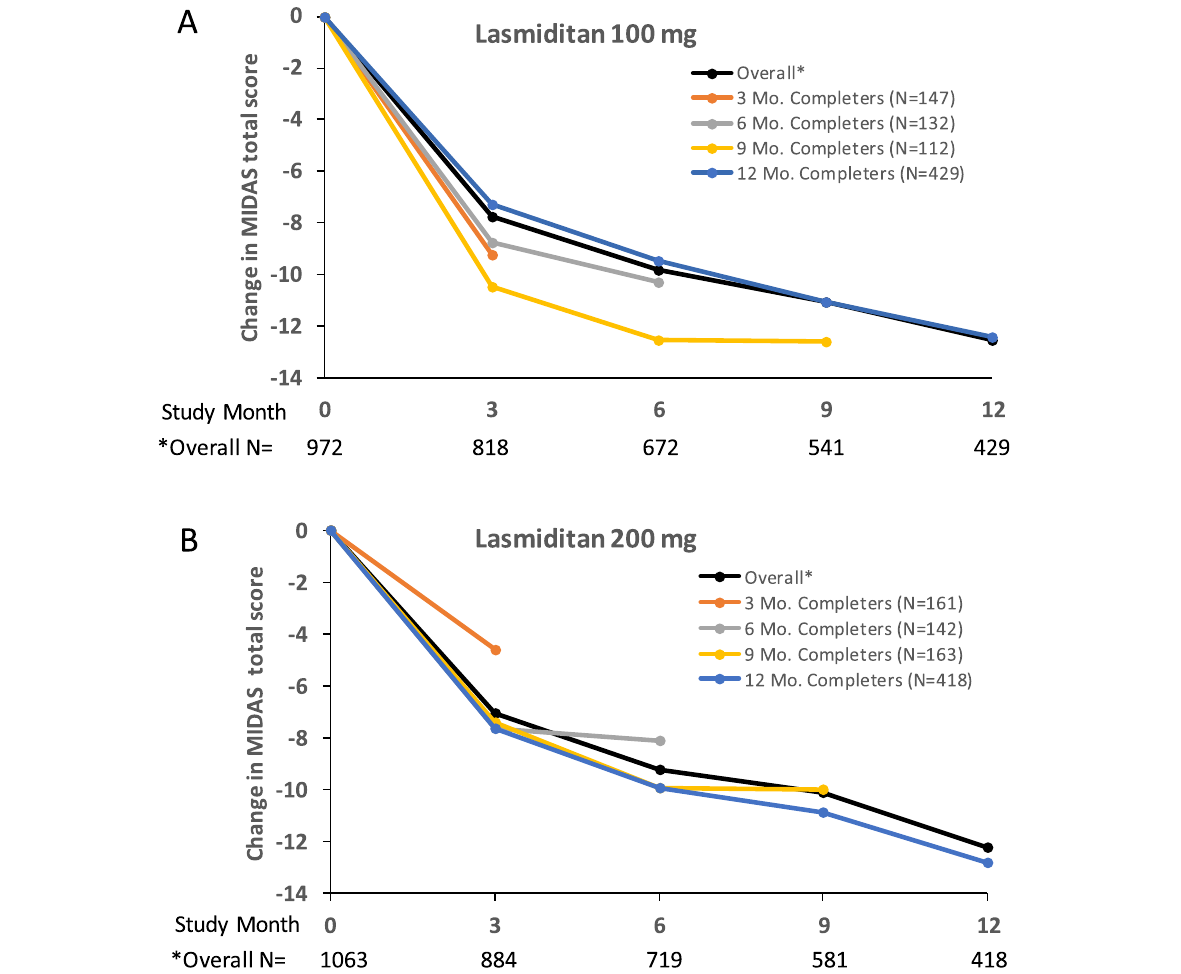
Fig. 1 Completer analysis showing MIDAS total score overall and for patients who completed a maximum of 3, 6, 9, or 12 months of study for a ) Lasmiditan 100 mg and b ) Lasmiditan 200 mg. Abbreviations: Mo. = month. Note that N within completer subgroups remained nearly constant (within 2 patients) across relevant